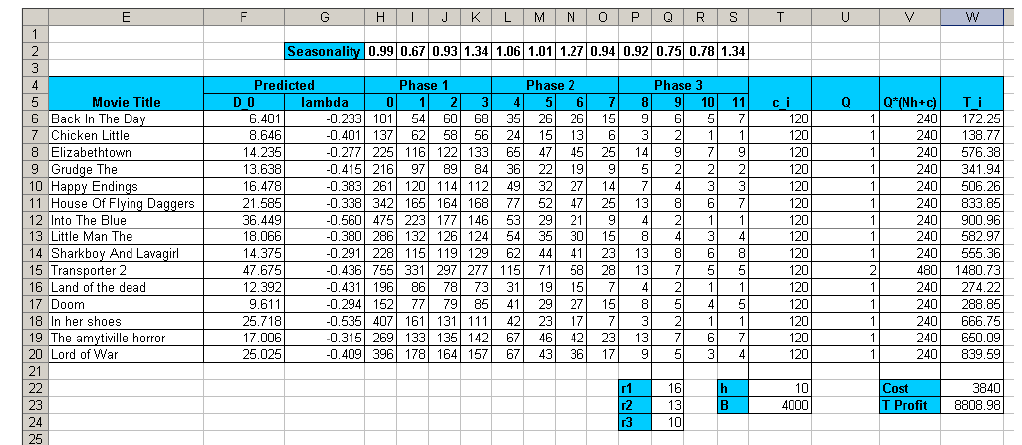
Figure 3: Spreadsheet implementation of PDM (Stage 2).